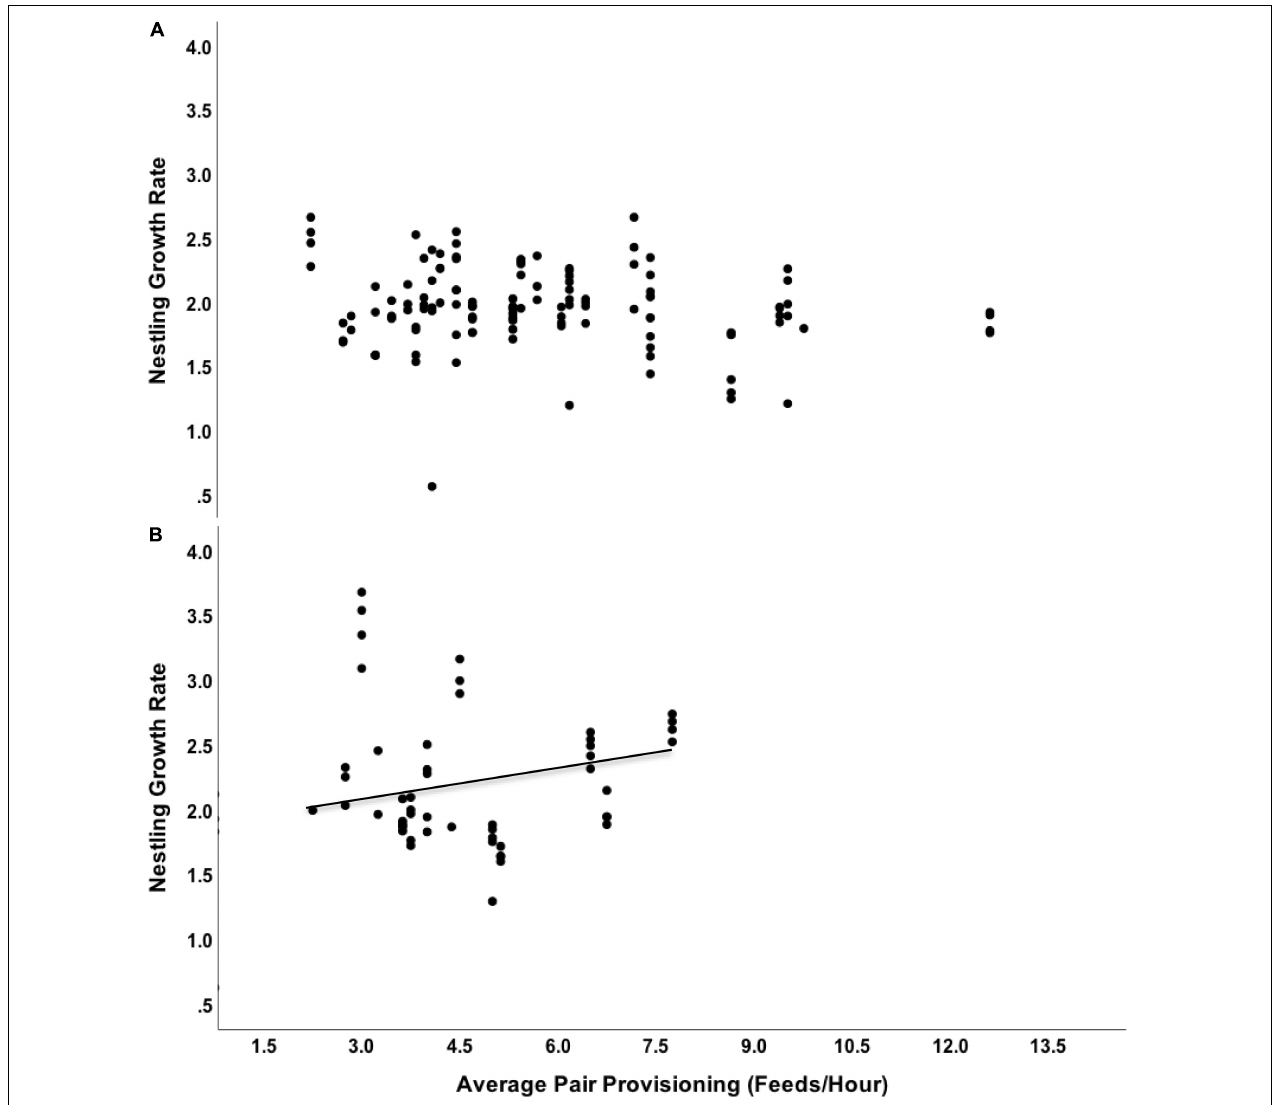
FIGURE 2 | Relationship between average provisioning rate of the pair (feeds/hour) on eastern bluebird nestling growth rate (g/day) split by areas of low (A) and high (B) tree swallow